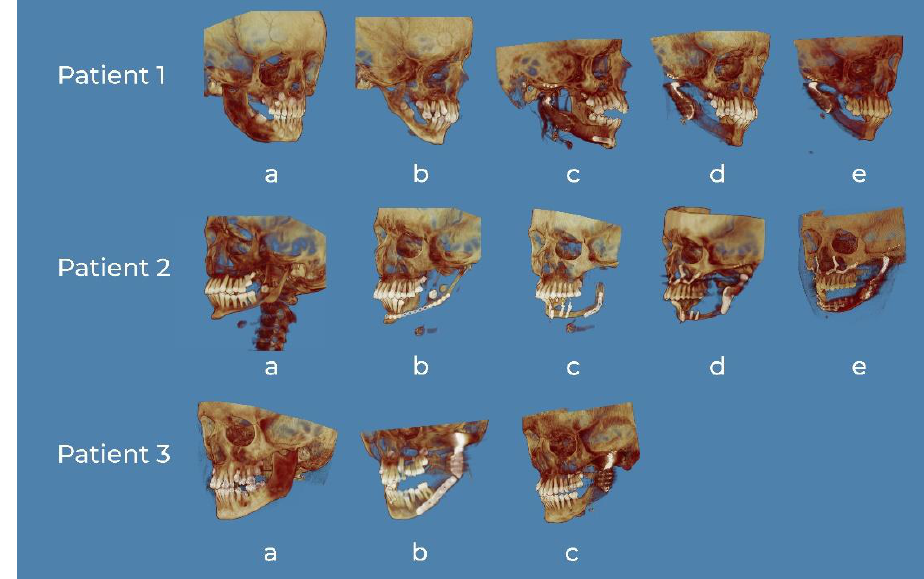
Figure 9. 3D CT reconstructions of representative patients . Patient 1 : (a) tumor of the right mandible body and ramus, (b) defect after nonradical resection in another department and secondary deformation, (c) 3D virtual surgical planning (VSP) reconstruction of the mandible and custom TMJ, (d) 6 months postoperative, and (e) 24 months postoperative. Patient 2: (a) tumor of the left mandible body and ramus, (b) defect after nonradical resection in another department and secondary deformation, (c) reconstruction of the mandible with fibula without 3D VSP in another facility — lack of functionality, (d) reconstruction of the TMJ with stock TMJ prosthesis and maxillary advancement in order to improve function and occlusion — failure due to resorption of the previous bone grafting, and (e) 3D VSP reconstruction of the mandible body, ramus and custom TMJ. Patient 3: (a) tumor of the left mandible body and ramus, (b) 3D VSP reconstruction of the mandible and custom TMJ, and (c) 4 years postoperative.